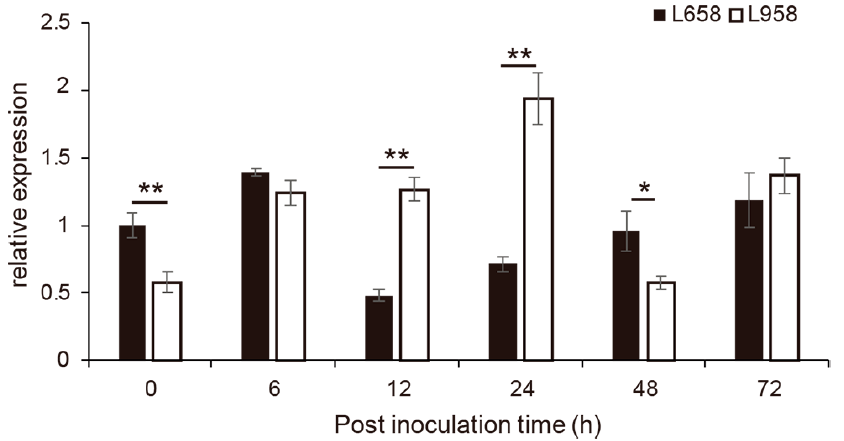
Figure 5. Relative expression changes of TraesCS7B01G164000 in the resistant line L658 and suscep- tible sister line L958 inoculated with powdery mildew. Statistical significance was determined using an independent sample t -test. The asterisks represent significant differences as follows: ** p < 0.01 and * p < 0.05. The asterisk at the top of the bars represents the difference between L658 and L958 interactions at each same time point.